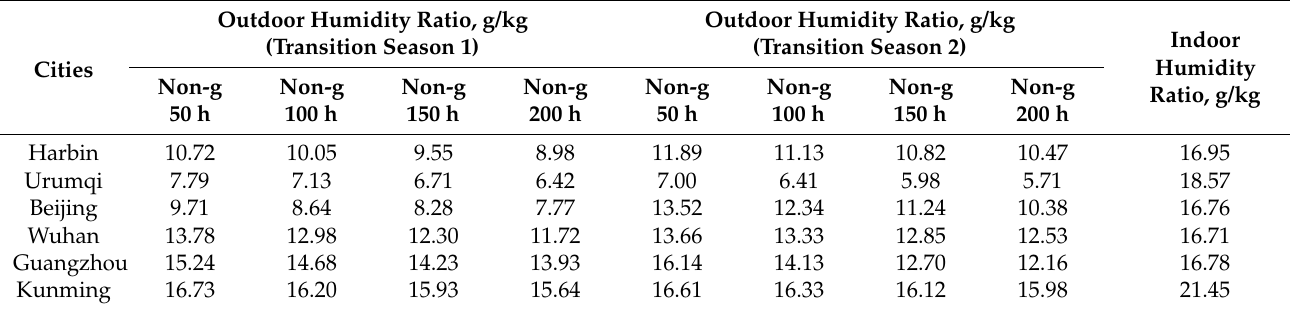
Table 5. Calculation results of indoor and outdoor humidity ratio in each city.